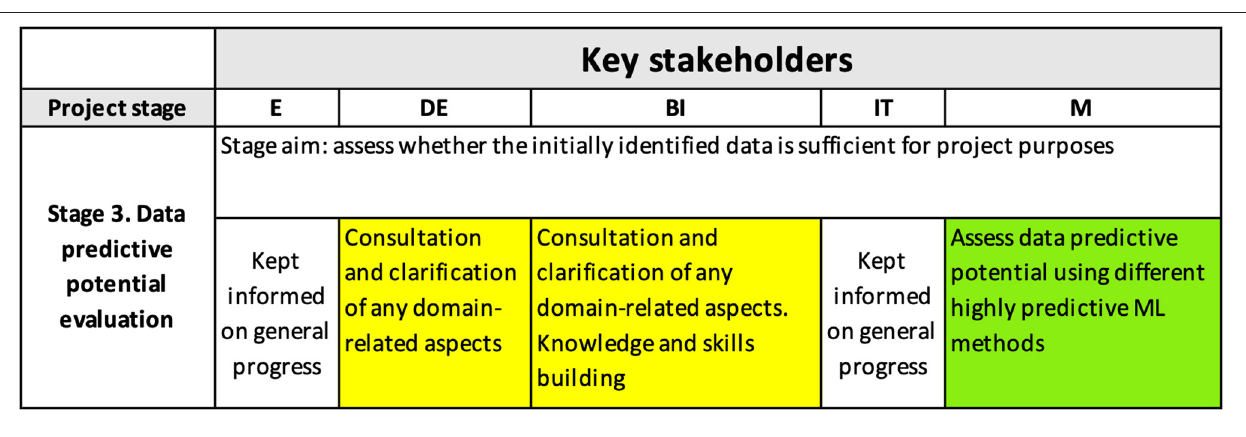
FIGURE 5 | Interpretability matrix content for Stage